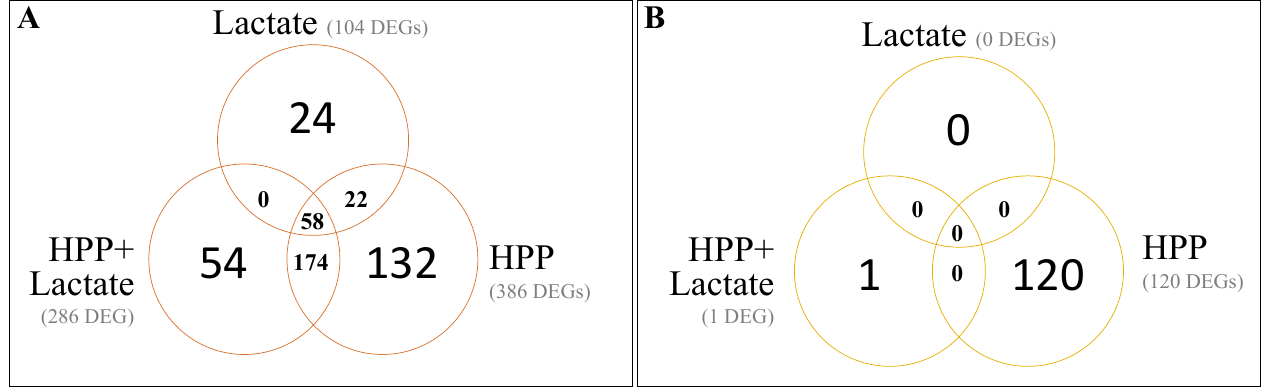
Figure 2. Venn diagrams of differentially expressed genes (DEGs) of L. monocytogenes strains CTC1034 ( A ) and EGDe ( B ) due to the exposure of cells to lactate, the application of the HPP (400 MPa for 10 min) and the application of both stresses compared to control conditions (exposed to CHMM without lactate).